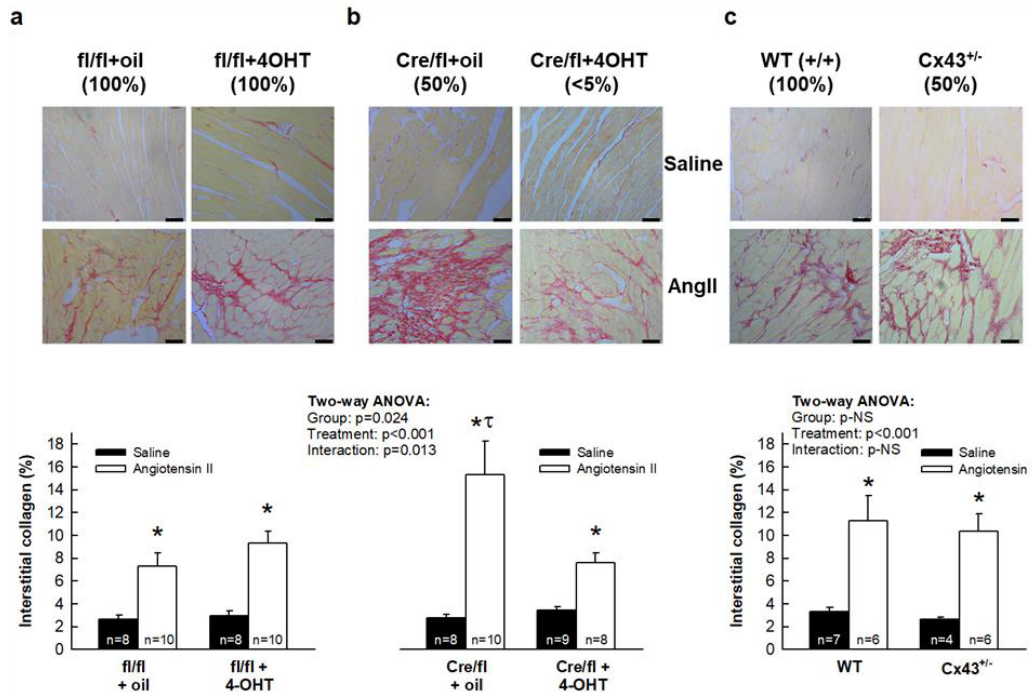
Figure 2. Cardiac fibrosis induced by AngII in Cx43 Cre-ER(T)/fl and Cx43 +/- mice. Representative images (upper panels) and mean quantification (lower graphs) of interstitial collagen deposition, expressed as percentage of total myocardial area, in Cx43 fl/fl (( a ) fl/fl) and Cx43 Cre-ER(T)/fl (( b ) Cre/fl) mice, after treatment, for 14 days, with saline or AngII. Bar represents 50 µ m. ( c ) shows changes in fibrosis in wild-type and Cx43 +/- animals. The approximate amount of Cx43 expression is indicated, in parenthesis, below the name of each group. * ( p < 0.05) indicates significant differences vs. the corresponding saline-treated group. τ ( p < 0.05) indicates significant di ff erences vs. all Cx43 fl / fl or Cx43 Cre-ER(T) / fl AngII-treated animals.